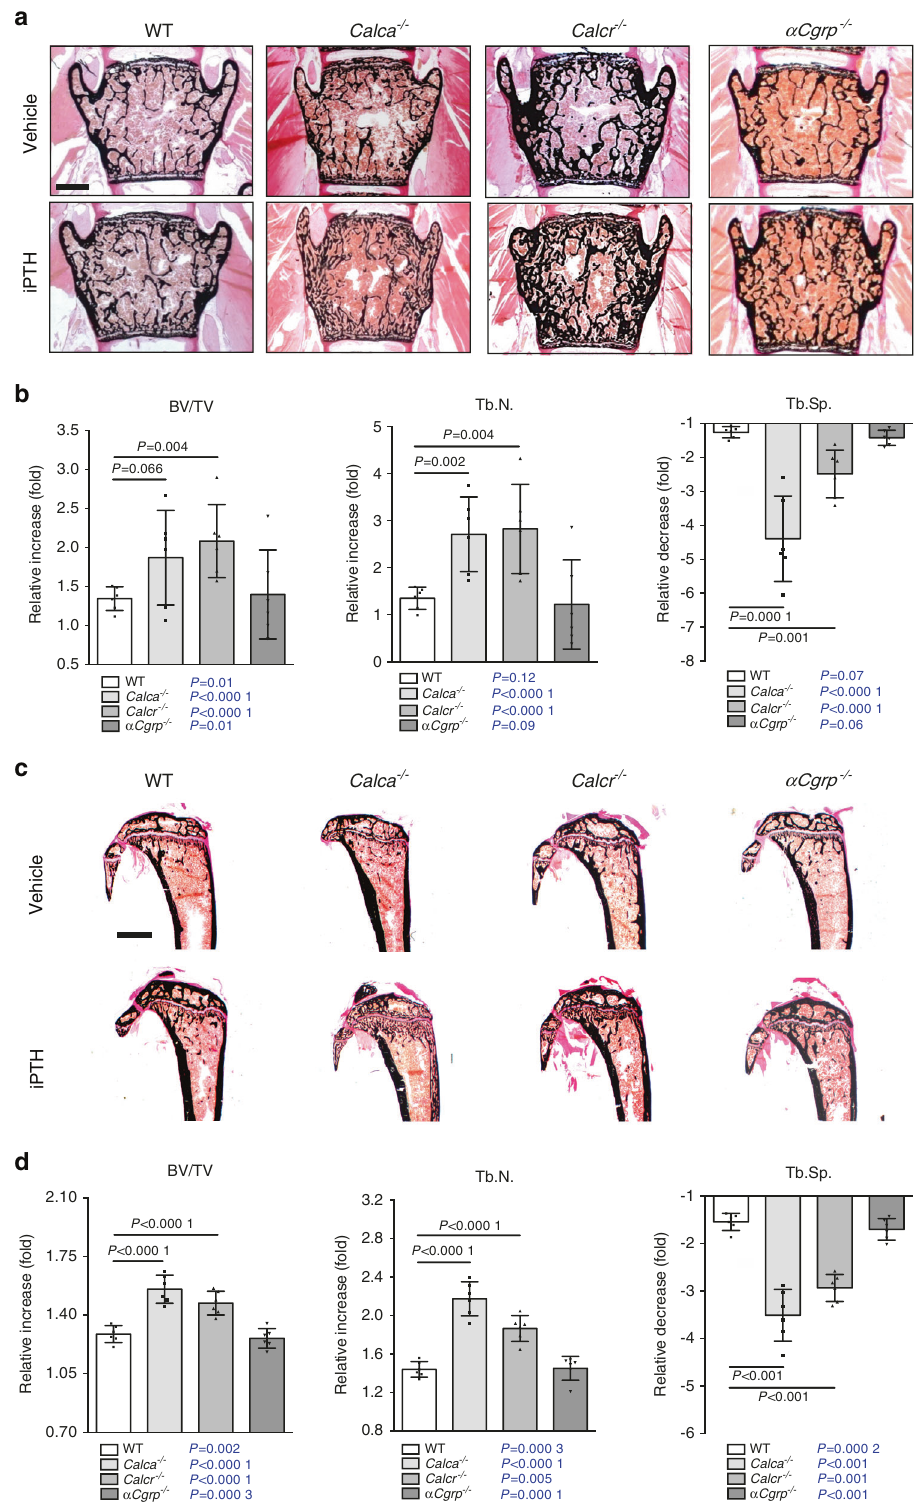
Fig. 2 iPTH-induced alterations in bone microarchitecture in Calca -de fi cient mice. a Von Kossa/van Gieson staining of undecalci fi ed vertebra sections (L4) from the indicated groups following 4 weeks of treatment with iPTH (100 μ g·kg − 1 ) or vehicle. Scale bar = 500 μ m. b Relative alterations (iPTH vs. vehicle) in the bone volume fraction (BV/TV), trabecular number (Tb.N.) and trabecular separation (Tb.Sp.), expressed as fold differences, in the same mice. c Von Kossa/van Gieson staining of undecalci fi ed tibia sections from the same mice. Scale bar = 500 μ m. d Relative alterations (iPTH vs. vehicle) in the bone volume fraction (BV/TV), trabecular number (Tb.N.) and trabecular separation (Tb.Sp.), expressed as fold differences, in the same mice. In ( a – d ), n = 5-6 mice per group (two-way ANOVA followed by Tukey ’ s post hoc test). In ( b , d ), the P values for the statistical comparison between vehicle vs. iPTH treatment in mice of the same genotype are indicated in blue (two-tailed Student ’ s t